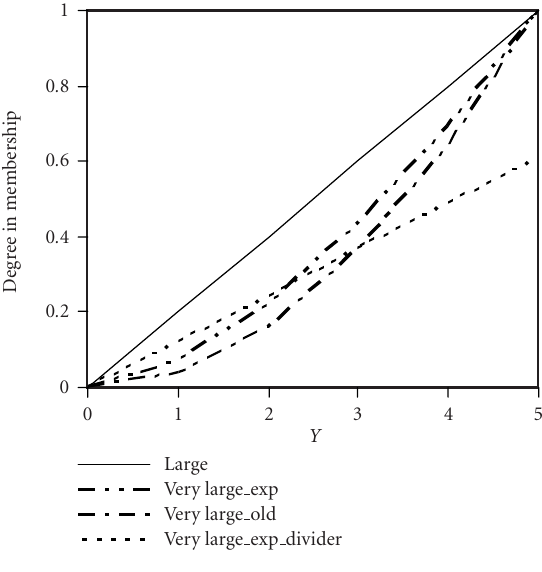
Figure 3.4. Schematic illustration of linguistic hedge “very” using exponentials.